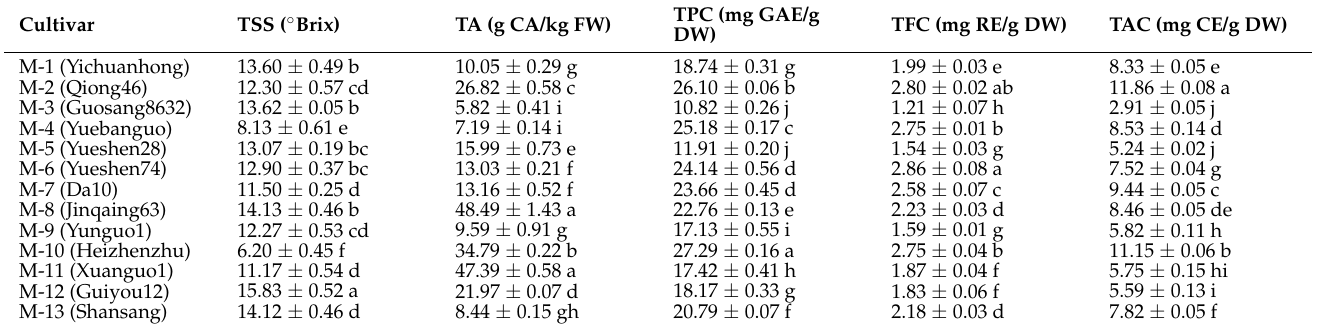
Table 1. The total soluble solids (TSS), the titratable acidity (TA), total phenolic contents (TPC), total flavonoid contents (TFC) and total anthocyanin contents (TAC) of mulberry samples. Cultivar TSS ( ◦